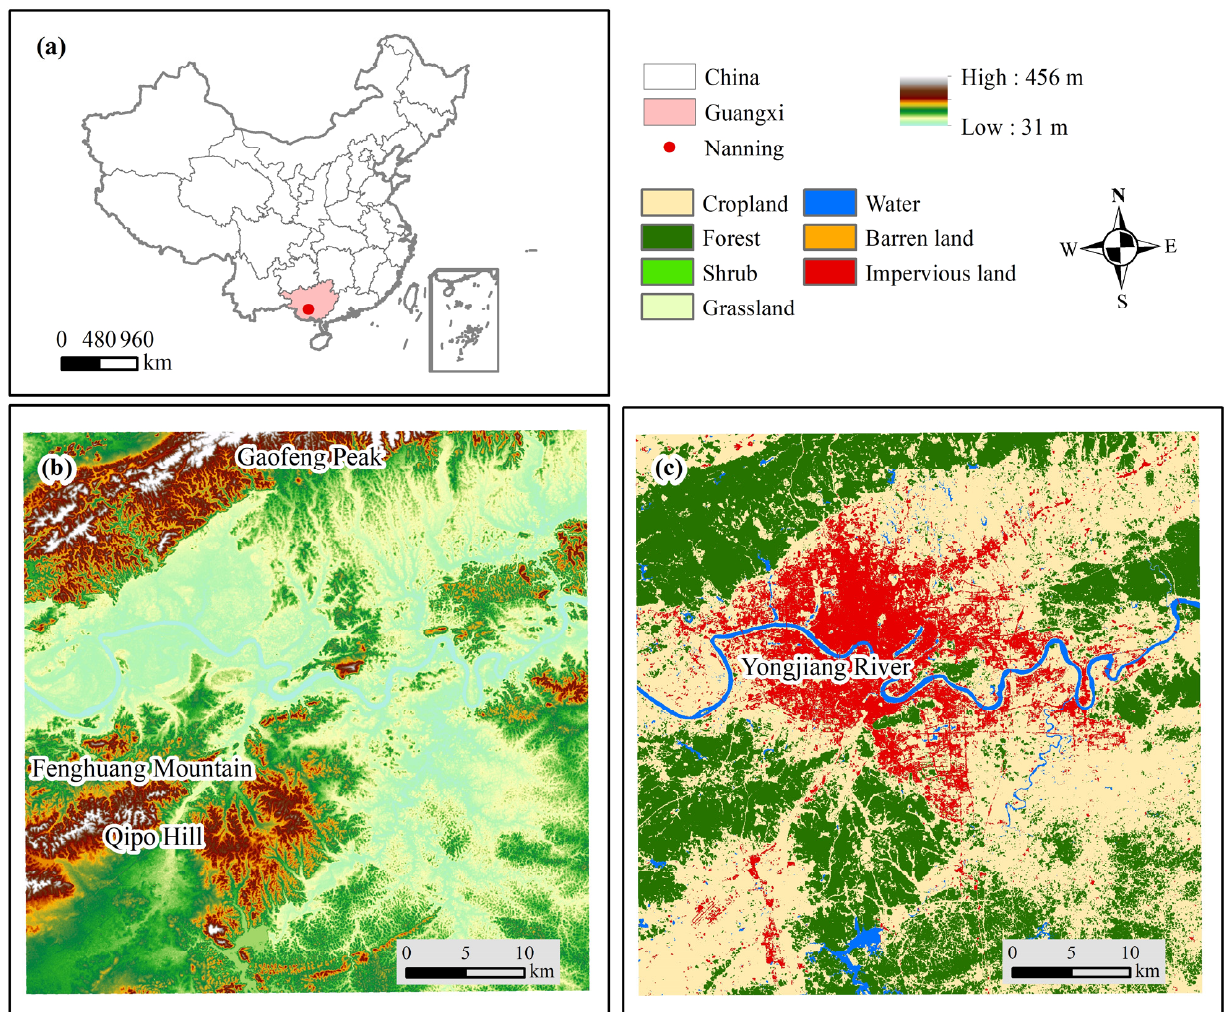
Figure 1. Location, elevation, and LULC of Nanning. ( a ) Location, ( b ) Elevation, ( c ) Land Use & Land Coverage.